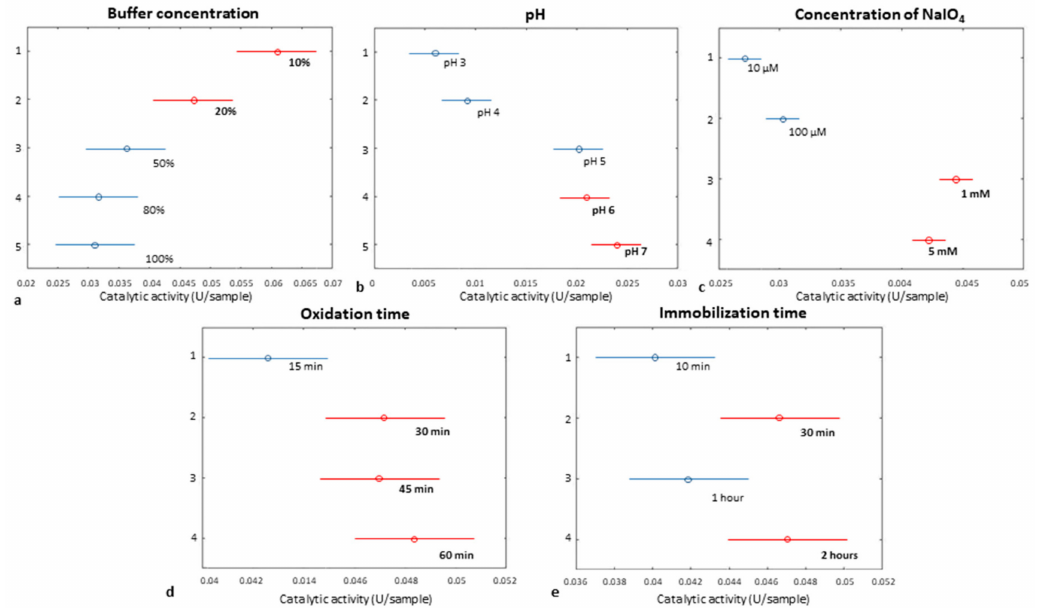
Figure 4. Statistical analysis of studied immobilization parameters using the multiple comparison test: optimal bu ff er concentration 10% and 20% ( a ); optimal pH 6 and 7 ( b ); optimal concentration of NaIO 4 1mM and 5mM ( c ); optimal oxidation time 30, 45, and 60 min ( d ); and optimal immobilization time 30 min and 2 h ( e